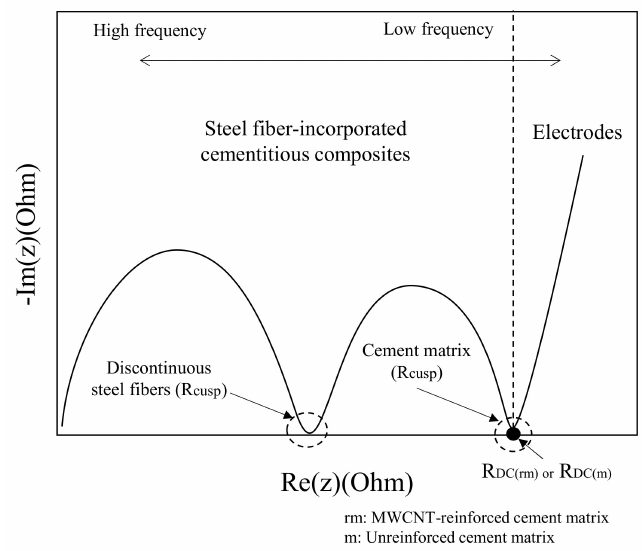
Figure 2. Typical Nyquist plots for steel fiber-incorporated cementitious